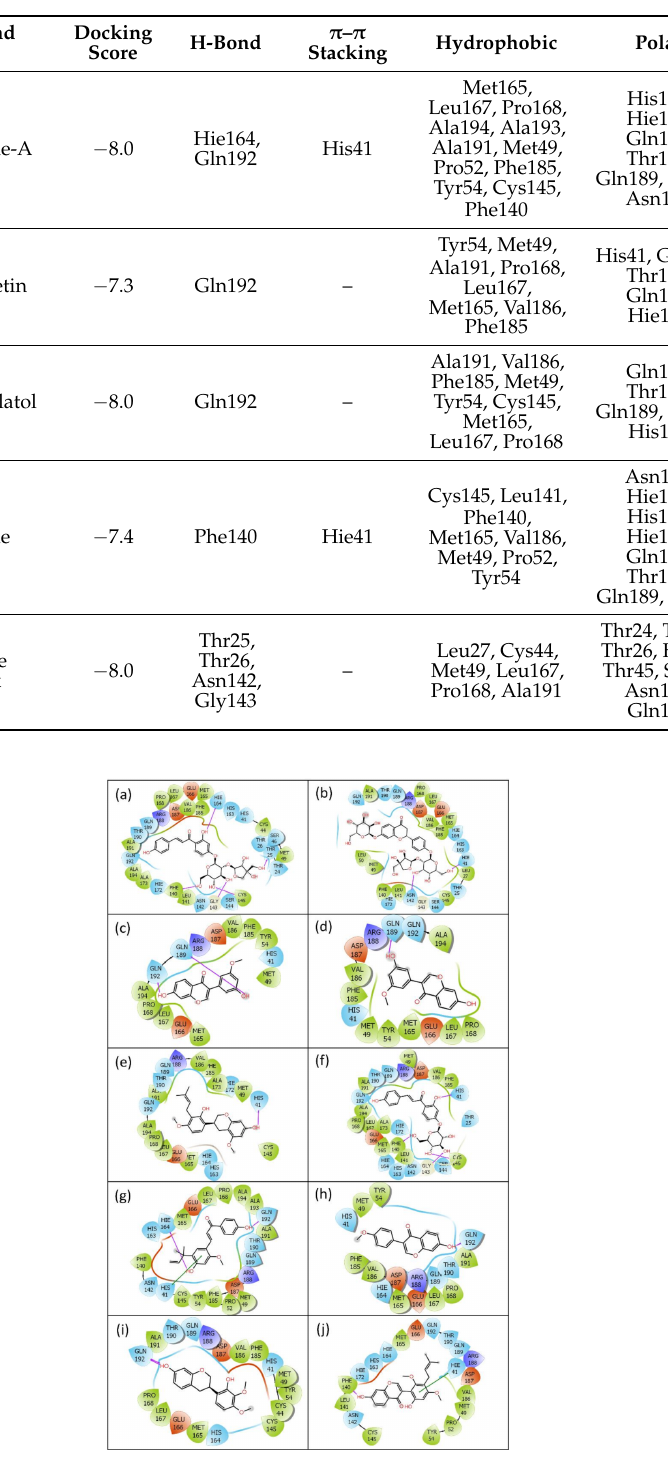
Figure 1. The 2D interaction poses for the docked poses of SARS-CoV-2 M pro with selected bioactive compounds: ( a ) licuraside, ( b ) glucoliquiritin apioside, ( c ) 7,3 (cid:48) -Dihydroxy-5 (cid:48) -methoxyisoflavone, ( d ) licuroside, ( e ) kanzonol R, ( f ) neoisoliquiritin, ( g ) licochalcone-A, ( h ) formononetin, ( i ) isomu- cronulatol, and ( j ) licoricone. Herein, hydrogen bond formation (pink arrows), hydrophobic (green), polar (blue), red (negative), violet (positive), glycine (grey), and π - π stacking (green line), interactions are also depicted in the respective docked